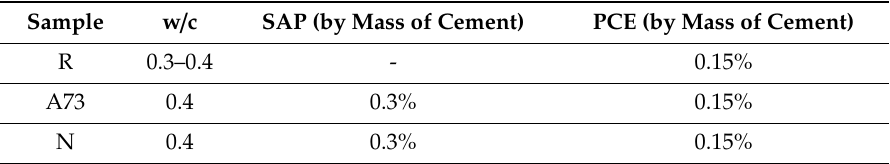
Table 1. Mixture proportion of the